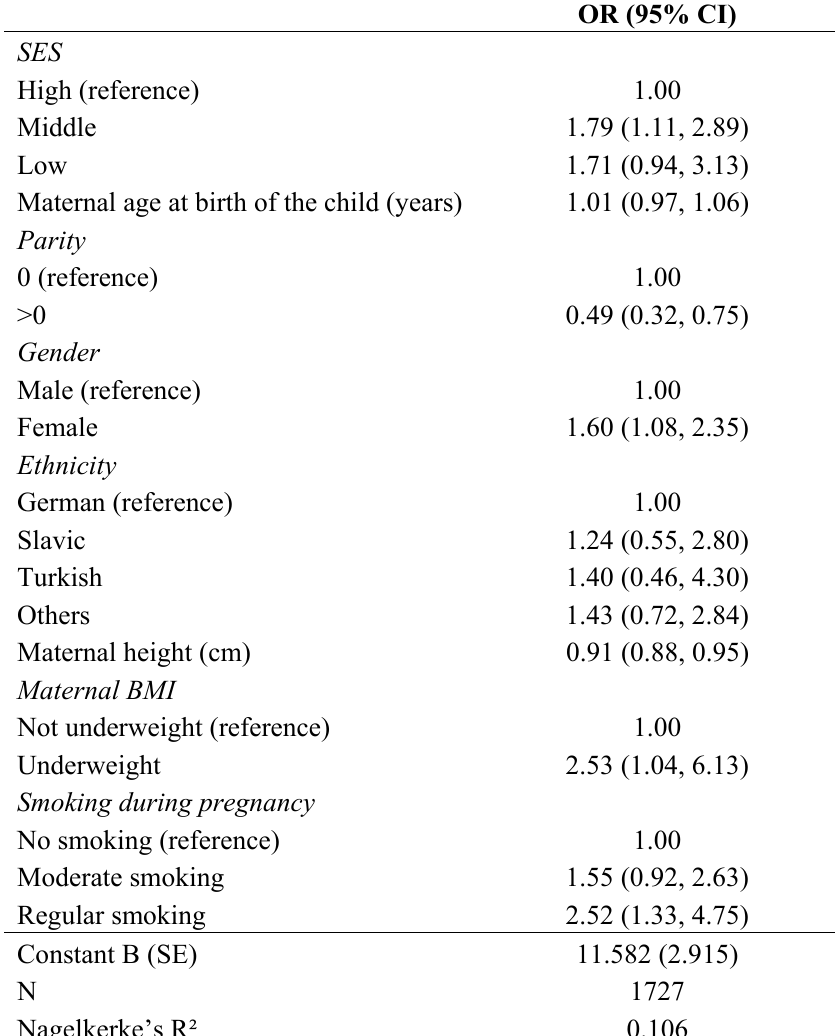
Table 4. Logistic regression model fitted on low birth